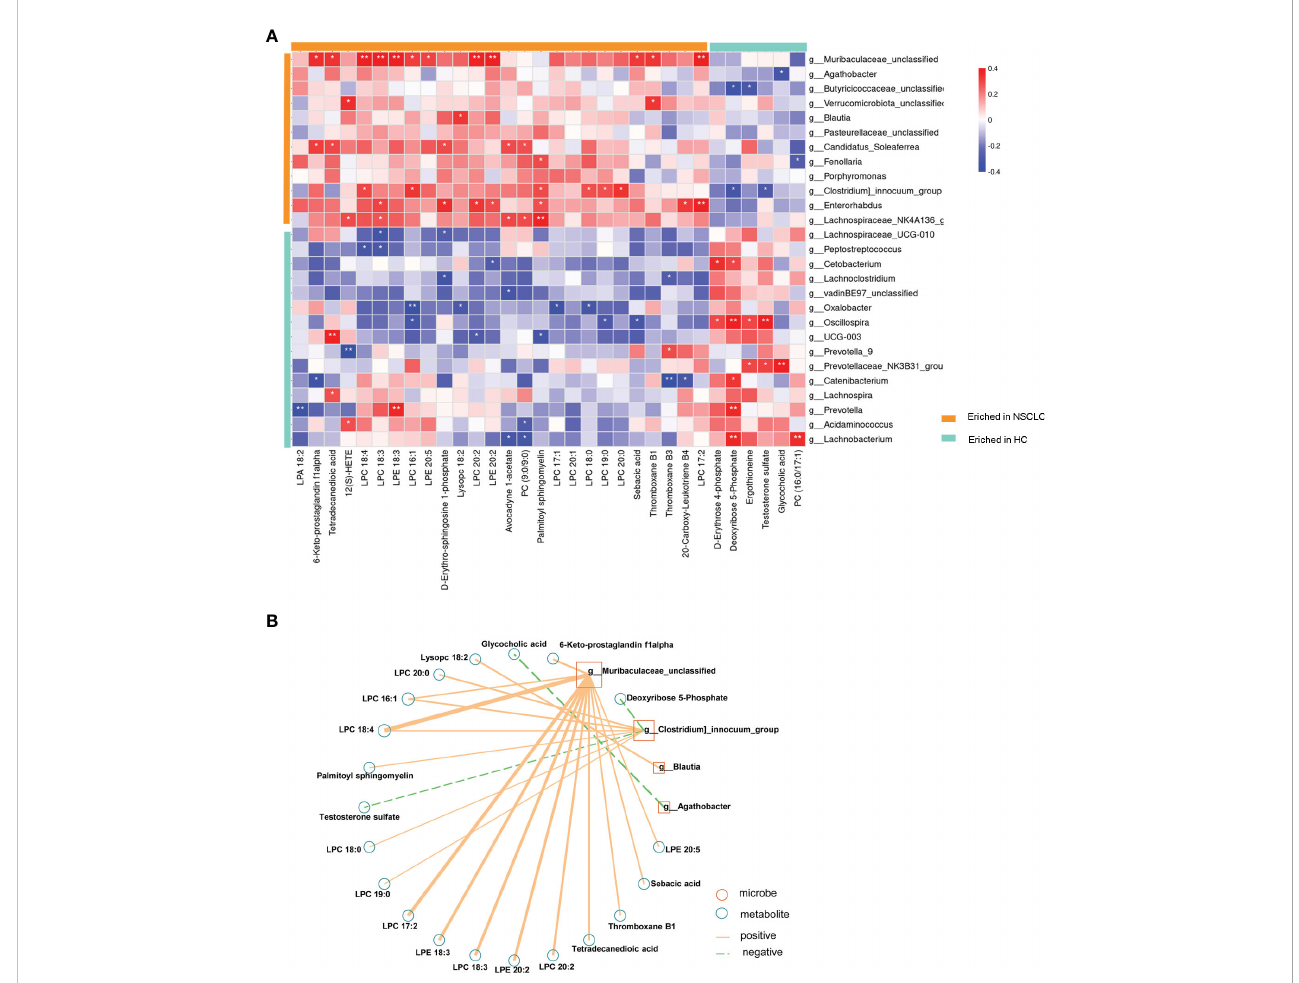
FIGURE 8 Multi-omics approaches revealed microbiota-metabolite interactions in early-stage NSCLC patients Heatmap demonstrates the correlations between 27 differentially abundant genera and 32 differentially abundant metabolites (Spearman ’ s correlation analysis). P-value, *p<0.05; **p<0.01; ***p<0.001 (B) Early-stage NSCLC associated networks based on integrated fecal microbiome and serum